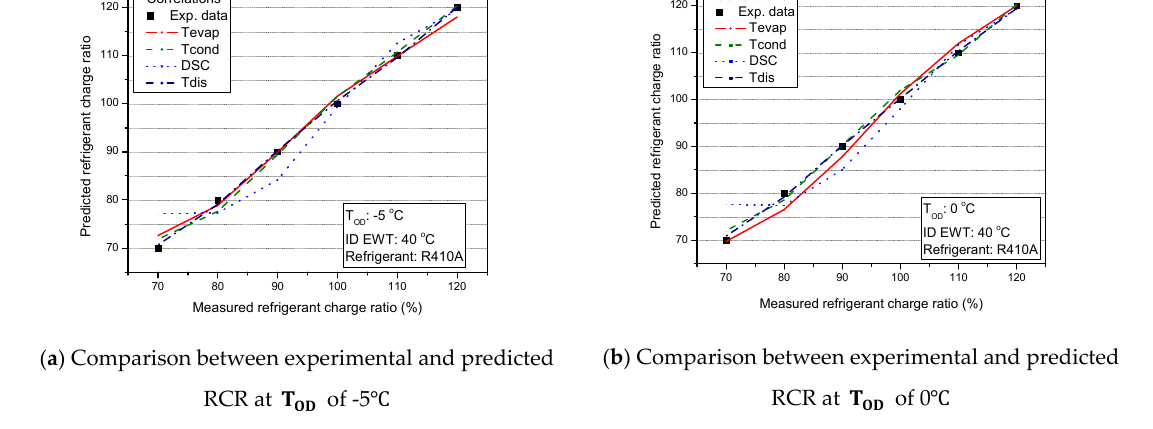
Figure 32. Cont ( b ) Comparison between experimental and predicted RCR at 𝐓 𝐎𝐃 of 0 ℃